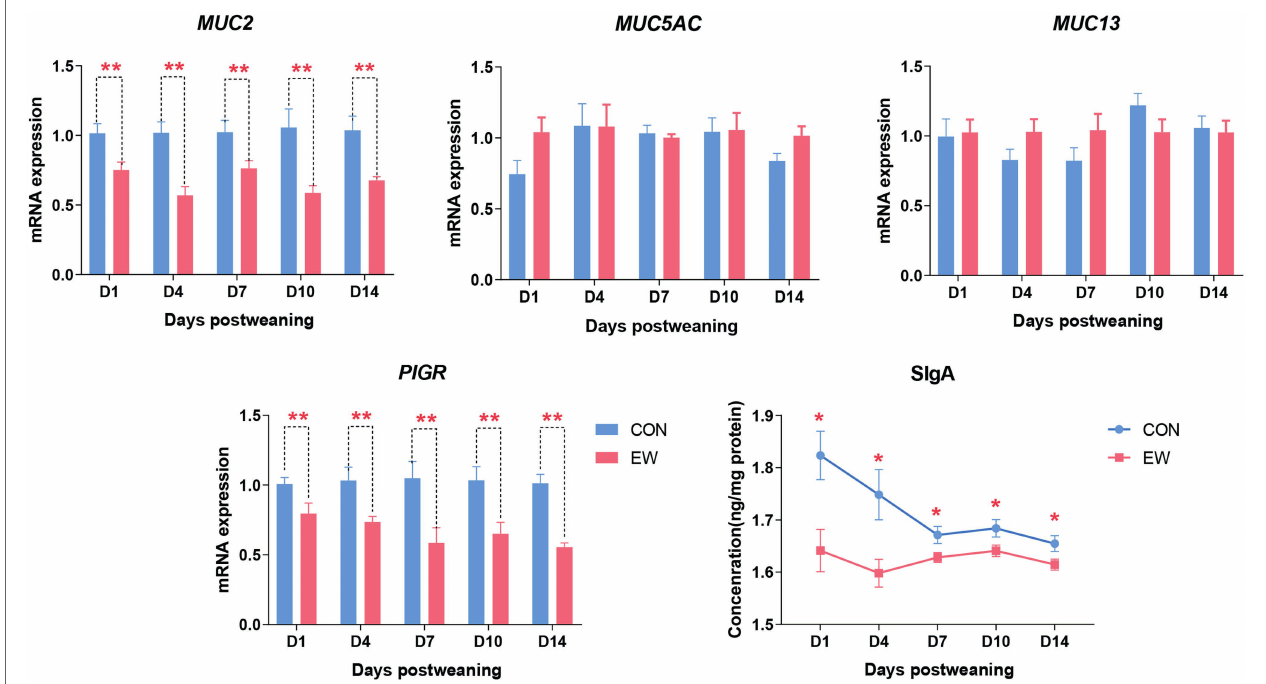
FIGURE 6 | Effects of early weaning on mRNA expression of mucins ( MUC ), polymeric immunoglobulin receptor ( PIGR ), and concentration of secretory IgA (SIgA) in the ileum of squabs. D1, D4, D7, D10, and D14 means 1, 4, 7, 10, and 14 days postweaning, respectively. Values are means with their standard errors of eight squabs. * and ** mean p < 0.05 and p < 0.01, respectively, within each time points postweaning. CON, control group; EW, early weaning